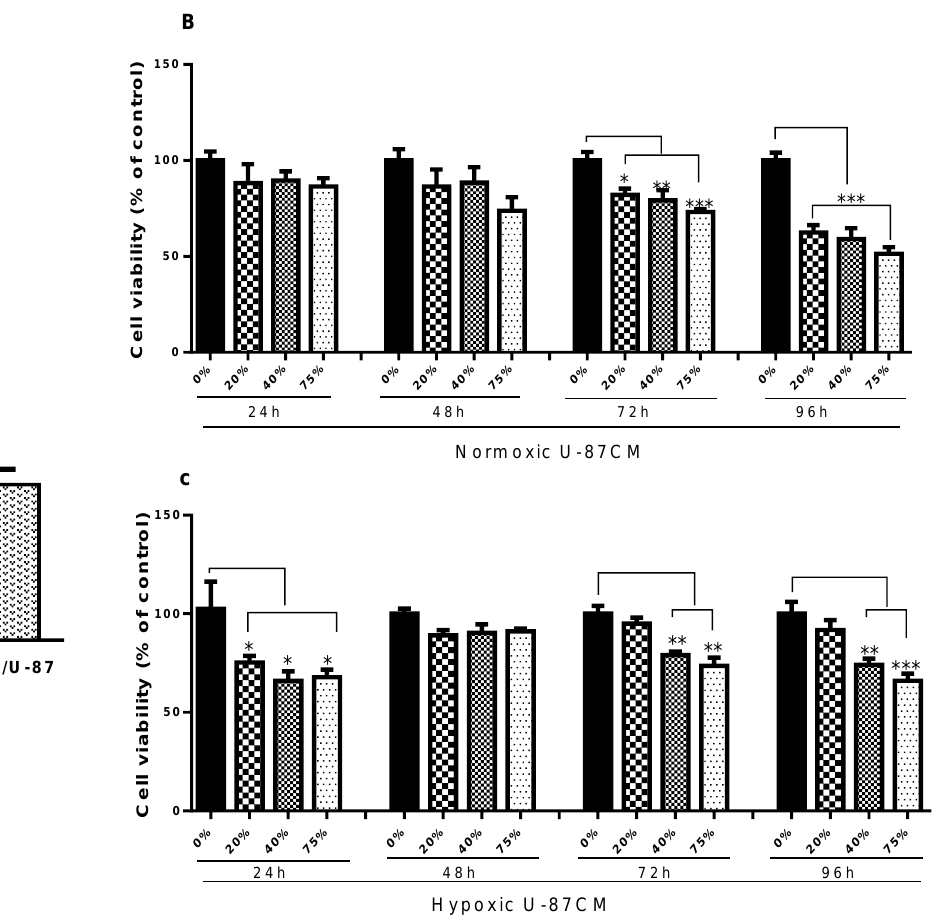
Figure 2. Graphs ( A – C ) show the viability of bEnd.3 cells under the influence of glioblastoma U-87 cells. ( A ) Shows the viability of monocultured bEnd.3 cells, compared with the bEnd.3 cells cocultured with glioblastoma U-87 cells. Cocultured cells showed a significant reduction in viability (* p < 0.04). ( B ) Shows cell viability of bEnd.3 cells exposed daily to selected concentrations of conditioned media produced from glioblastoma U-87 cells (U-87CM) cultivated under normoxic incubation (21% O 2 ) (* p < 0.05, ** p = 0.0011, *** p < 0.001). The results show that the viability of cells significantly decreased at all concentrations of conditioned media at 72 and 96 h of incubation. ( C ) Represents cell viability of bEnd.3 cells after daily exposure to U-87CM derived during hypoxic (5% O 2 ) incubation. Viability was significantly reduced at all concentrations of conditioned media after 24 h incubation, and only at 40% and 75% concentrations of conditioned media after 72 and 96 h incubation (* p < 0.05, ** p < 0.01, *** p = 0.0008), but showed no significant difference to controls across all concentrations of conditioned media at 48 h of incubation, ( n = 4).